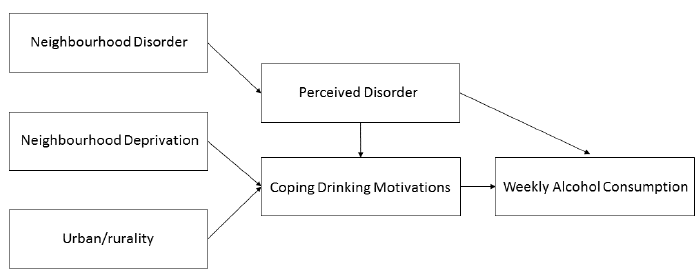
Figure 2. Path model of neighborhood conditions on Scottish adolescent weekly alcohol consumption with only significant paths